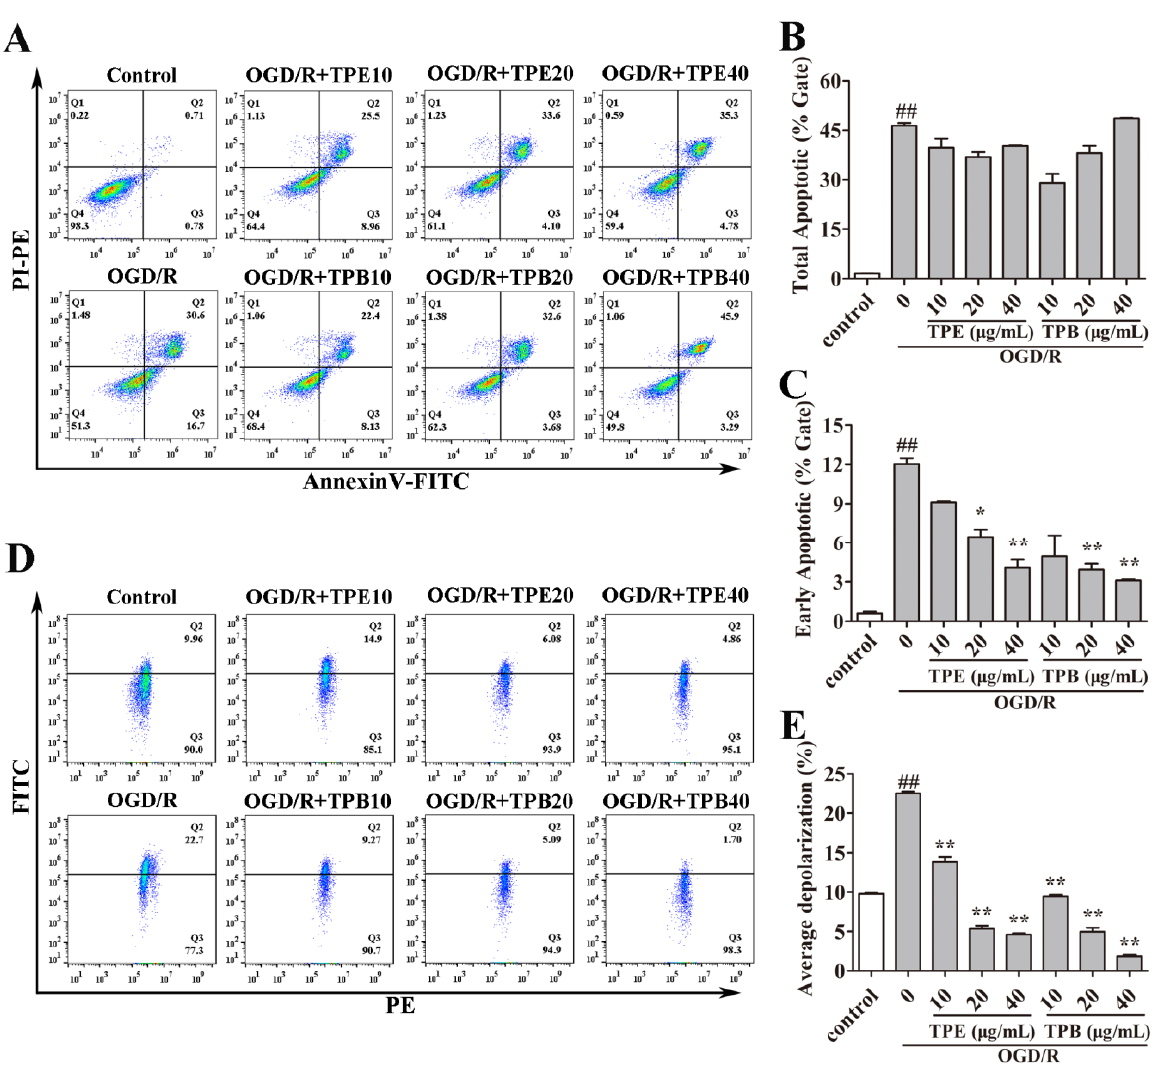
Figure 3. TPE and TPB ameliorated OGD/R injury by reducing early cell apoptosis and maintaining mitochondrial membrane potential. ( A ) Flow cytometer images of cell apoptosis are shown. ( B ) We calculated the total apoptotic ratio by measuring FITC and PI fluorescence. ( C ) Quantification of early apoptotic ratio is shown. ( D ) Flow cytometer images of MMP are displayed. ( E ) Quantification results of JC-1 monomers (green fluorescence) compared with JC-1 aggregates (red fluorescence) labeled using JC-1 probe are shown. ## p < 0.01 vs. control group; * p < 0.05, ** p < 0.01 vs. OGD/R group.